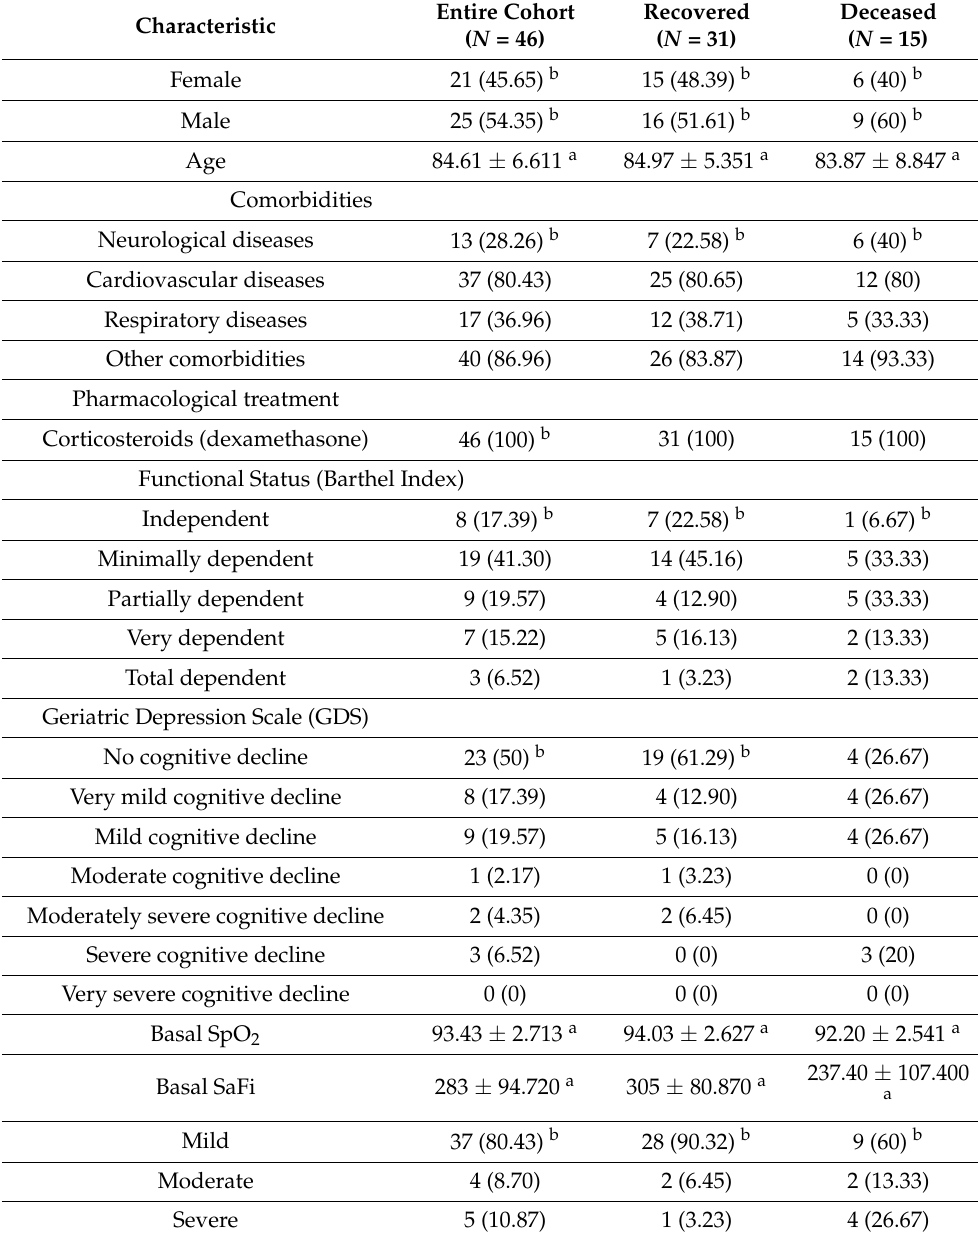
Table 1. Baseline demographic and clinical characteristics of COVID-19